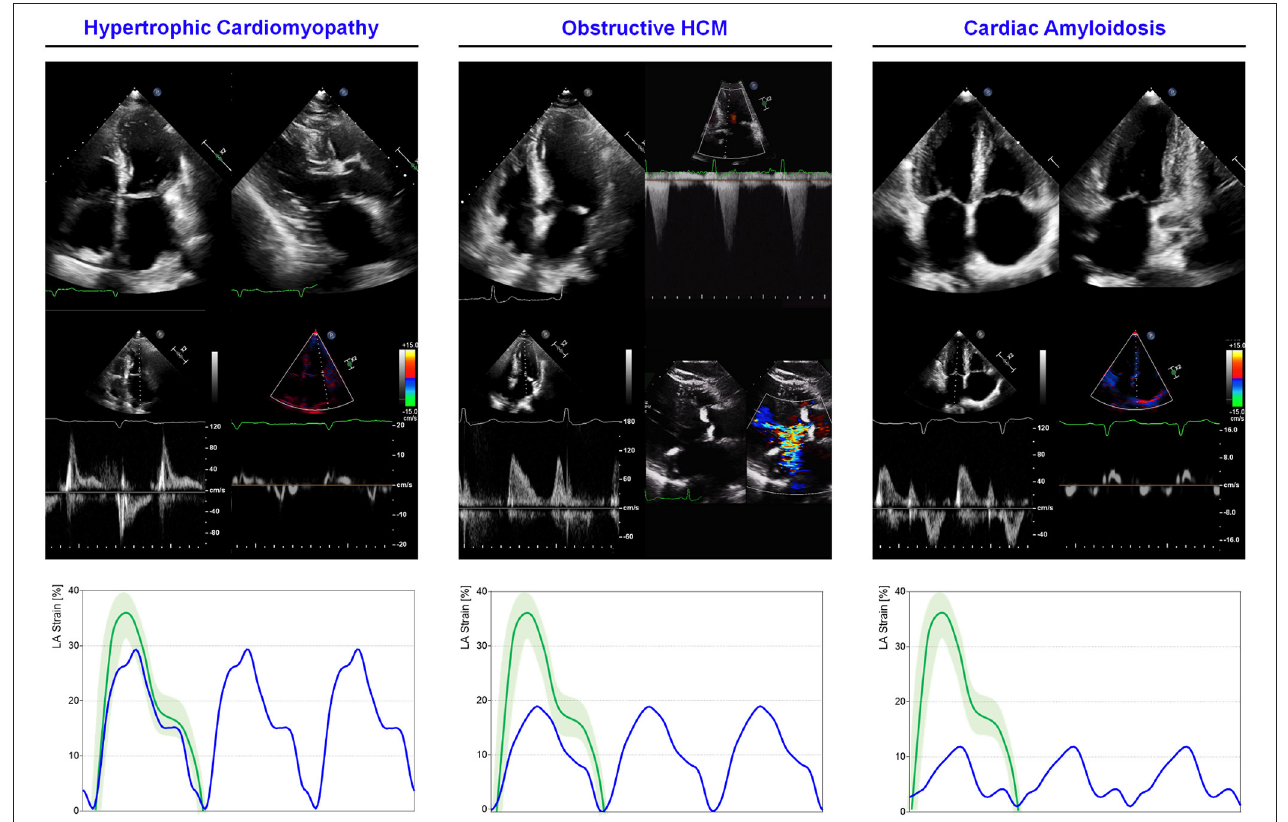
FIGURE 5 | LA mechanics in cardiomyopathies: Examples of echocardiographic images and LA strain are shown for (left) non-obstructive HCM, (middle) obstructive HCM and (right) AL cardiac amyloidosis. Strain traces are cartoons realized with real values of the reported cases. Reference values for LA strain are shown in green. Note that non-obstructive HCM presents severe diastolic dysfunction while obstructive HCM has a greater impairment of reservoir function; AL cardiac amyloidosis presents very depressed reservoir function consistent with severe diastolic dysfunction and LA amyloid infiltration. Abbreviations as in the